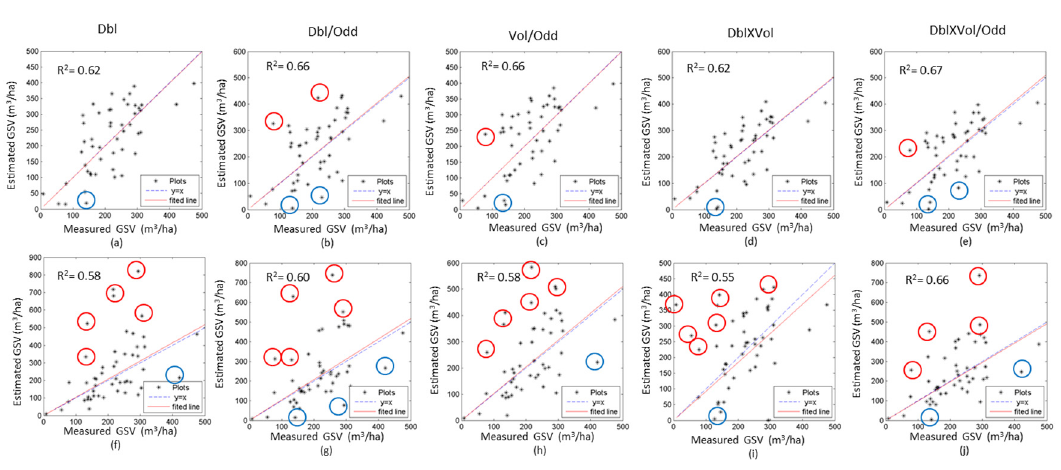
Figure 9. The scatter diagrams between the observed and the estimated GSV of the plots with the time series SAR images (1, 2, 3 and 4). The results using GLM (a–e) and semi-exponential model (f–j) are shown with difference variables. Red circle and blue circle denote over-estimated and under-estimated GSV, respectively.